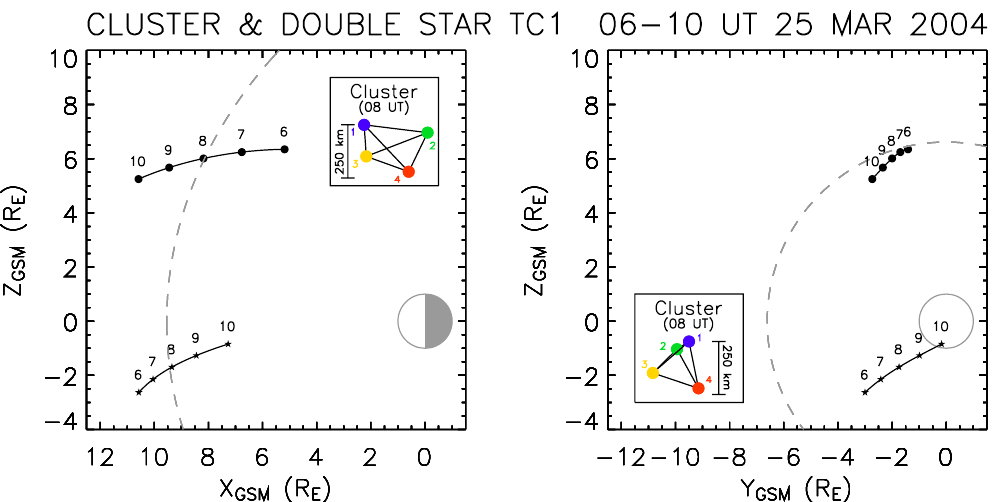
Fig. 1. The locations of the Double Star TC1 and Cluster spacecraft projected into the GSM X-Z and Y-Z planes (left- and right-hand panels respectively) during the the interval 06:00–10:00 UT on 25 March 2004. The positions of the TC1 and Cluster 1 spacecraft are indicated at 1h intervals (stars and circles respectively) and labelled according to universal time. In each figure, the tetrahedral configuration of the four Cluster spacecraft at 08:00 UT is shown in the